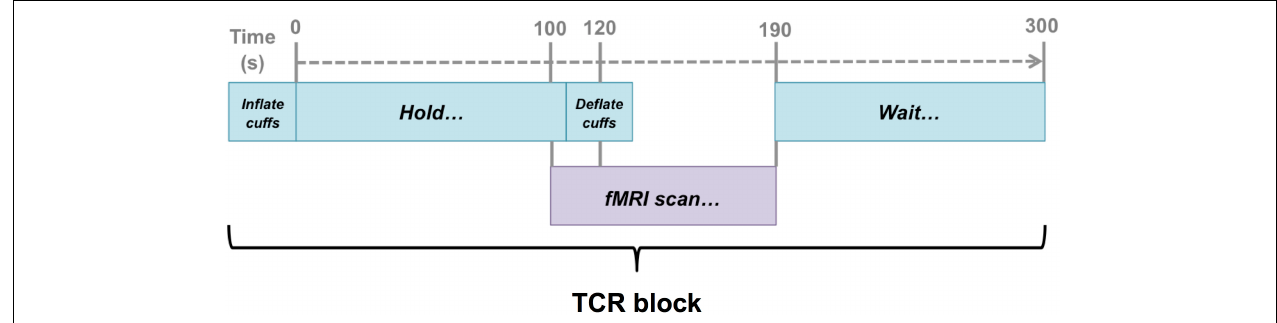
FIGURE 1 | Schematic illustration of the timing of the fMRI scans with respect to the TCR challenge. Scans were timed such that they captured a 20 s baseline before the TCR onset, and then allowed 70 s for the TCR response to evolve (40 s in the case of 2 subjects).